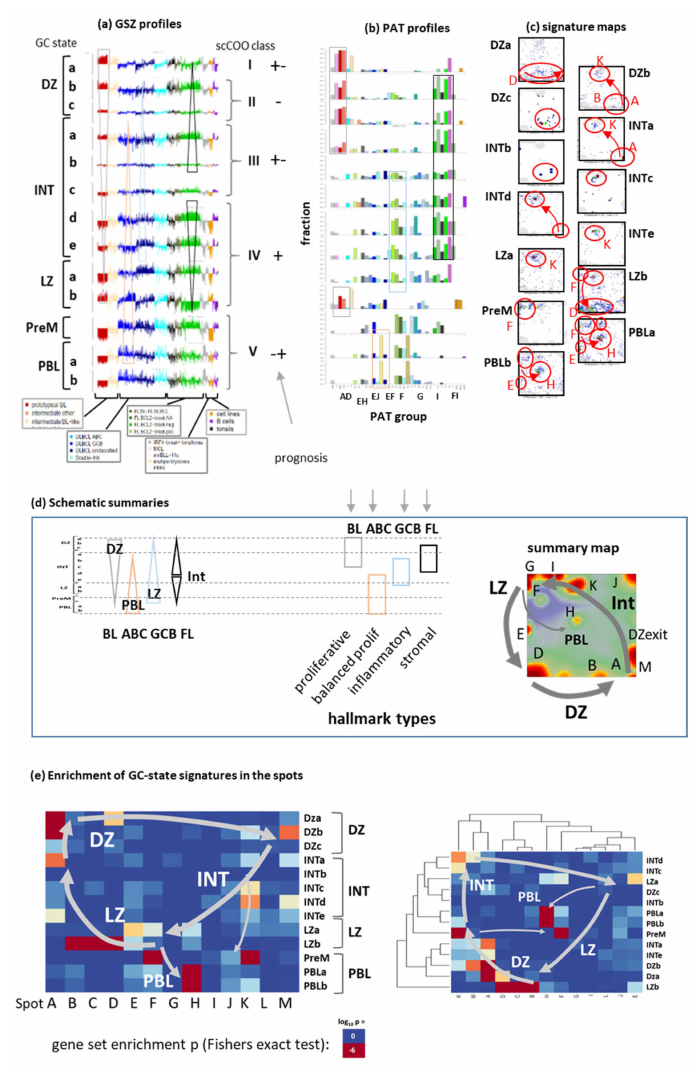
Figure A6. Mapping B-cell states in the GC as identified by Holmes et al. in [24] into the lymphoma transcriptome landscape: ( a ) GSZ profiles across the lymphoma reveals subtype specific up and downregulation, where upregulation in BL, ABC, GCB and FL associates with DZ, PBL, LZ and Int, respectively. Note that LZb upregulates in BL, ABC, GCB and DHL as well. scGC states were accumulated in scCOO prognostic classes I–V with inferior ( − ) via intermediate ( − +, + − ) to good (+) prognosis (see [24] for details). ( b ) Pattern type profiles in units of the fraction of the PAT per GC state. ( c ) Maps of the signature genes of the 13 GC states. Areas of accumulation are shown by ellipses. ( d ) Schematic summaries of ( a – c ) The triangles symbolize changing activities in the respective subtypes (left part). The PATs were summarized into four hallmark types with largest fractions in the specific subtypes as indicated. The summary map visualizes the GC trajectory in the lymphoma SOM. Letters assign relevant spots. ( e ) Enrichment of the GC-state gene signatures among the spot-modules of the transcriptomic landscape. Supervised (unclustered) and two-way clustered heatmaps of − logp (Fishers exact test) enrichment values. The GC-circle is indicated by arrows. It transforms into the picture shown in the SOM landscape in part ( d